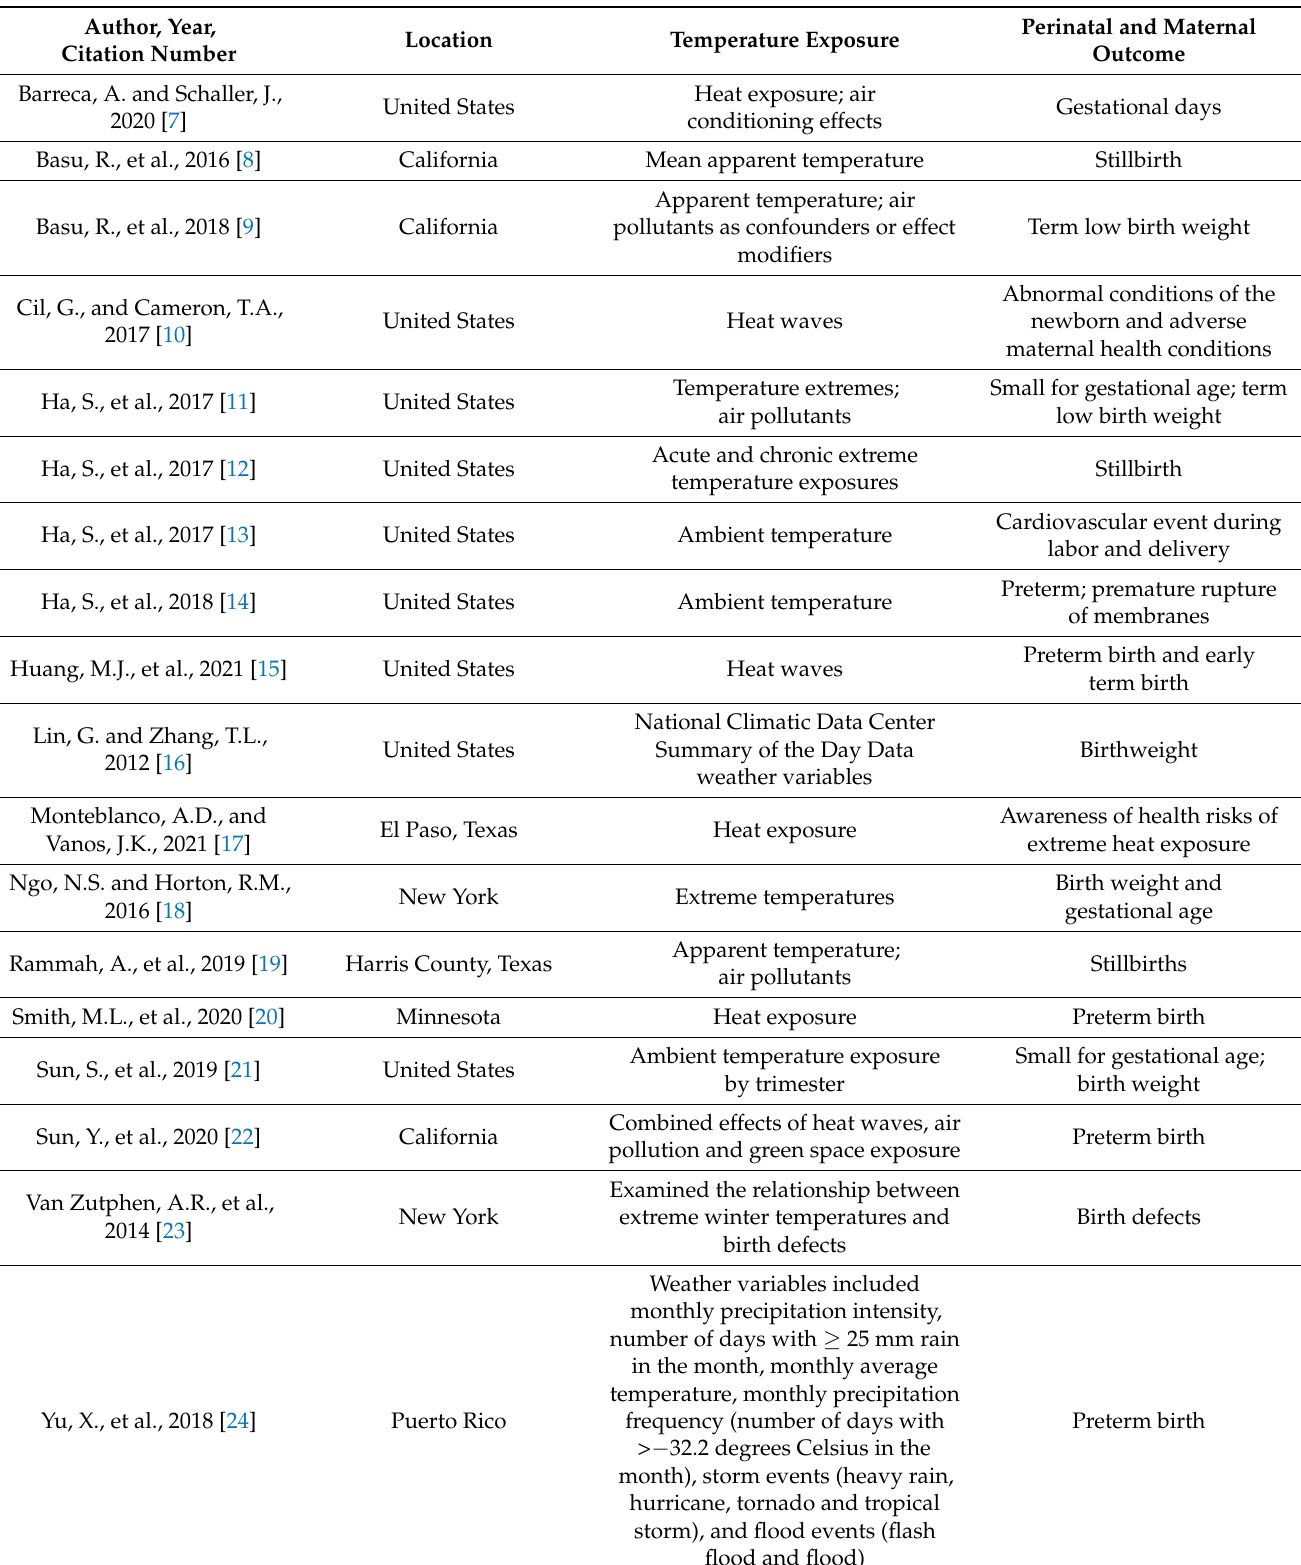
Table 2. Temperature Exposure Studies ( n =